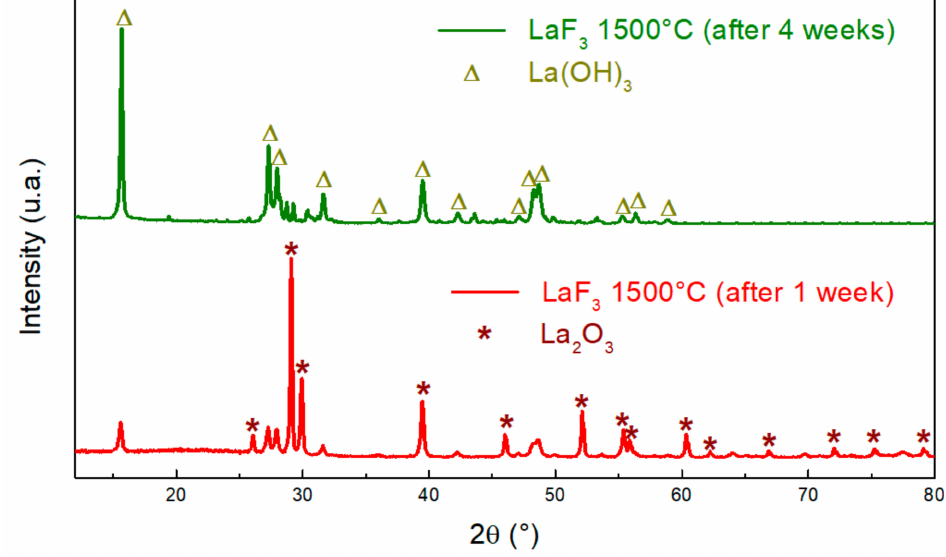
Figure 4. XRD patterns of the LaF 3 heated at 1500 ◦ C after 1 week (red) and after 4 weeks (green). Consequently, the thermal treatment of LaF 3 at very high temperature leads to the formation of La 2 O 3 , which is a compound confirmed by EDX measurements with average atomic percentages very close to those theoretically calculated (Table 4). The presence of fluorine in very small quantity (0.9%) is always observed, which is probably